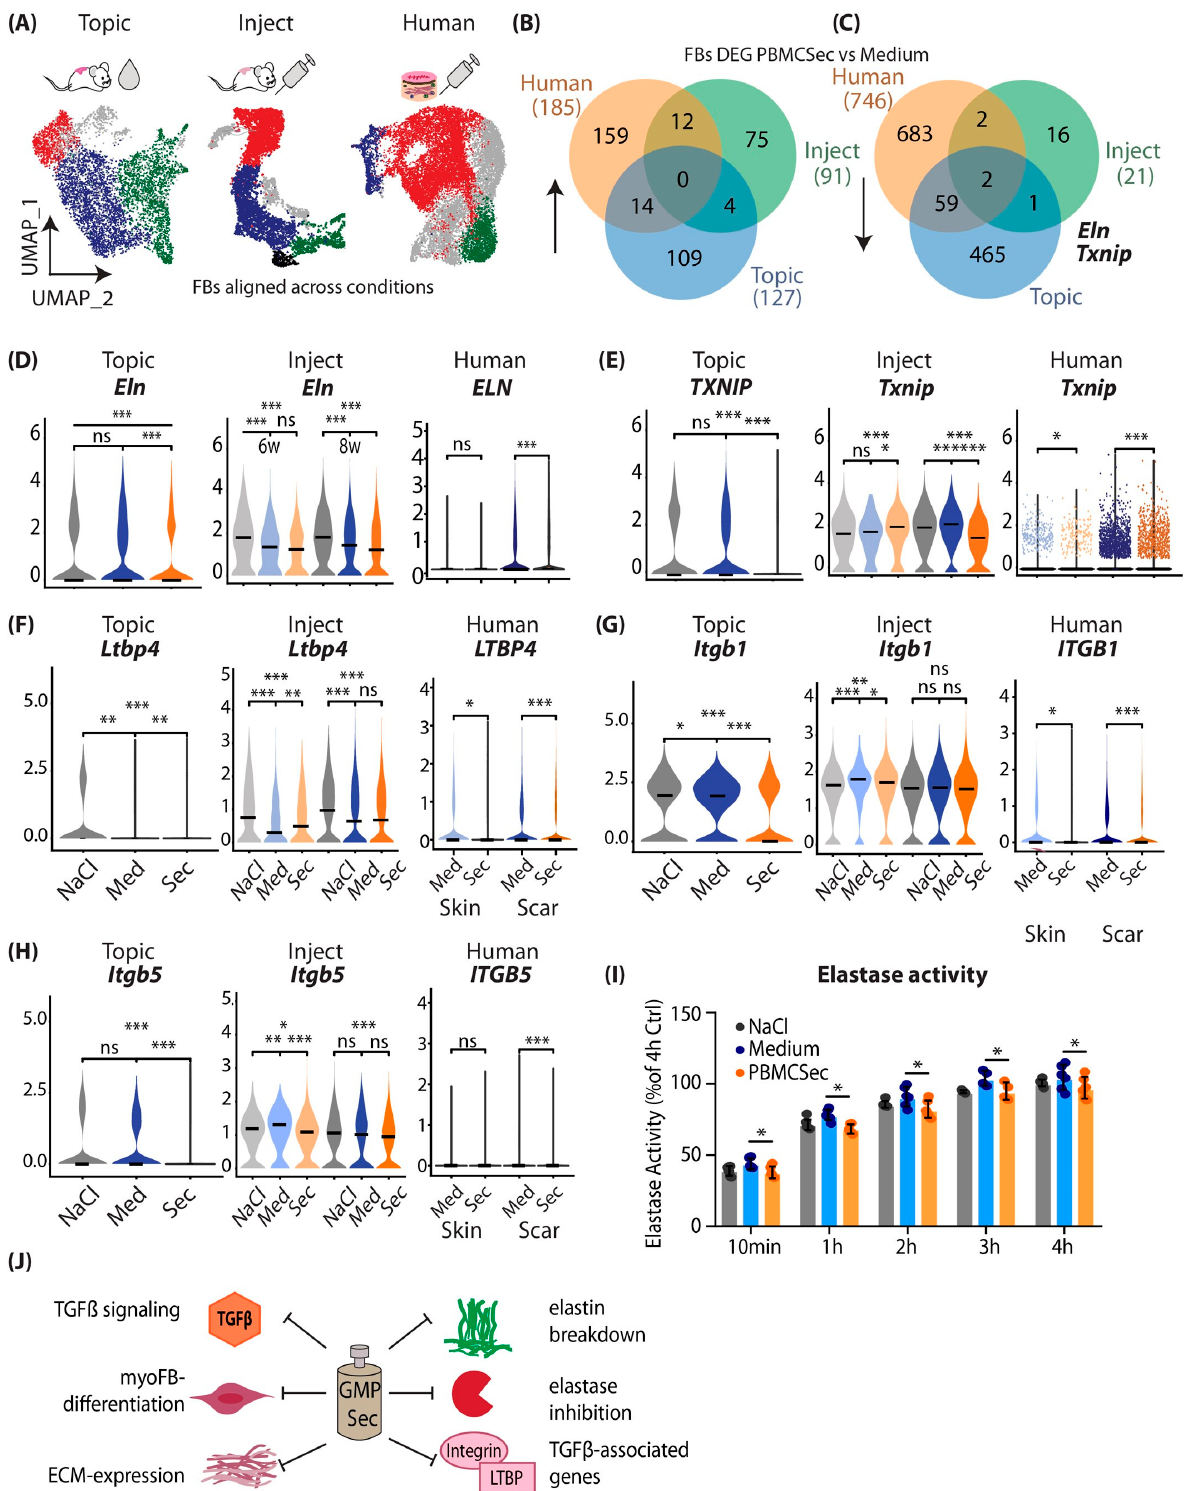
Figure 6. Combined analysis of murine and human scRNAseq datasets reveals elastin as joint key player of beneficial PBMCsec effects. ( A ) Subclustering of FBs in “mouse topical”, “mouse inject”, and “human” scRNAseq datasets, and FB subcluster alignment. Red, cluster A; blue, cluster B; green, cluster C; aligned by cluster markers (Figure S9). ( B ) Venn diagram of overlap of significantly upregulated and ( C ) downregulated genes in FBs in all three datasets. ( D – G ) Violin plots of ( F ) latent TGF β binding protein 4 (Ltbp4/LTBP4) and ( G , H ) Integrin subunit beta 1/5 (Itgb1/5/ITGB1/5) in datasets. ( I ) Elastase assay with fluorescence-marked pig pancreas elastase, with NaCl, medium,